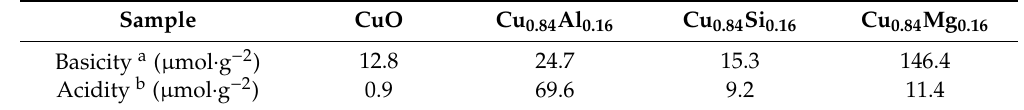
Table 2. Acid-base properties of the catalysts.